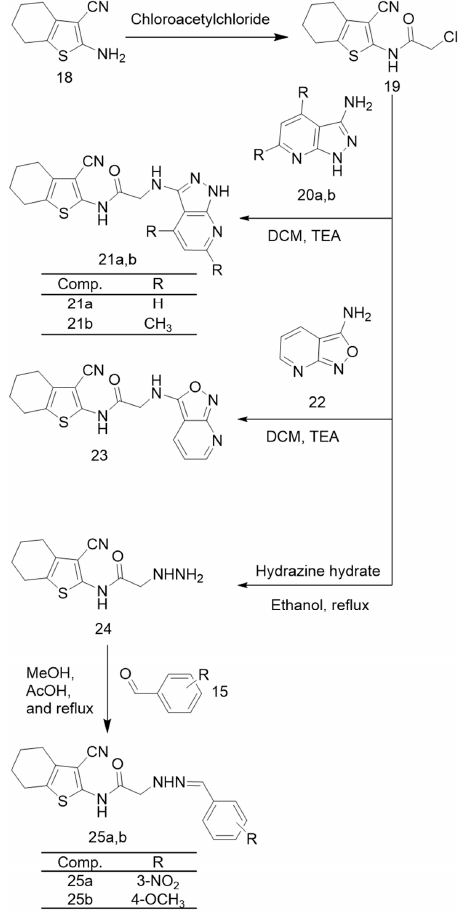
of compounds ( 14 – 17a ) showed multiple peaks of aromatic protons in the range of 7.80 to 8.70 δ (ppm) and a single peak for CH proton in the range of 7.4 to 8.4 δ (ppm). The spec- trum of compound ( 15a ) showed a single peak corresponding to OH proton at 10.15 δ (ppm), and the spectrum of compound ( 16a ) showed a single sharp peak at 4.06 δ